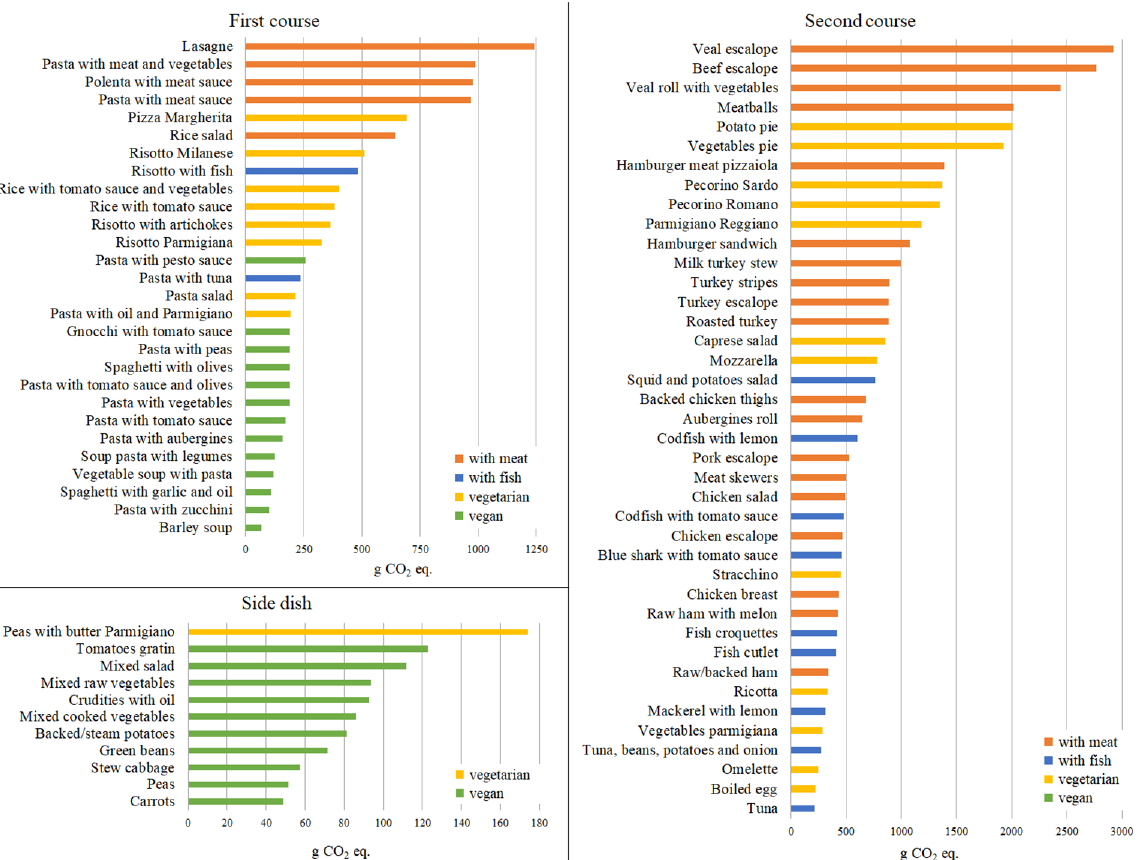
Figure 3. Carbon footprint (CF) of the analysed meals: first courses, second courses and side dishes.